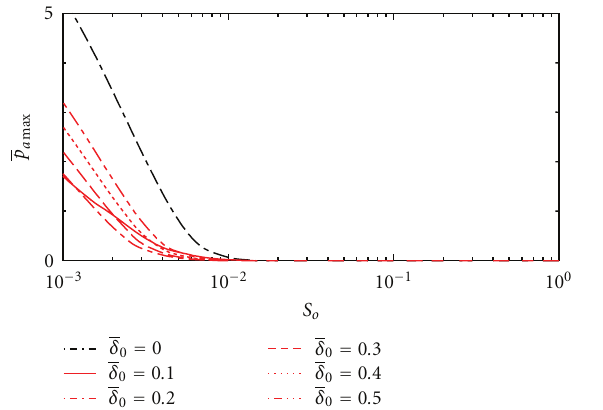
Figure 6: E ff ect of dent δ o on maximum asperity-contact pressure . p amax